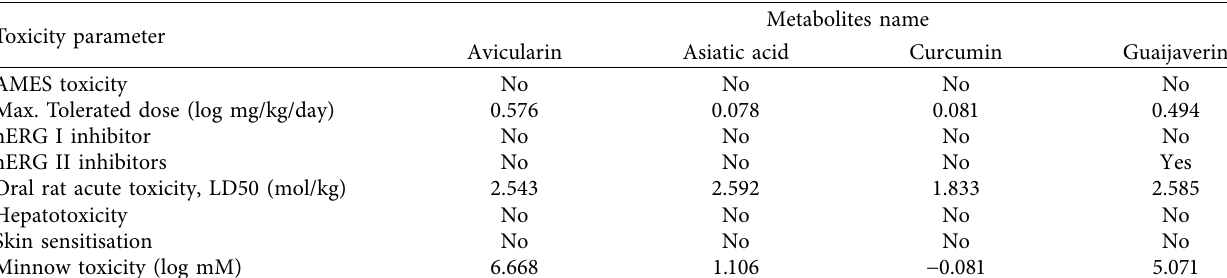
Figure 9: ADME properties of selected metabolites (a) avicularin, (b) Asiatic acid, (c) curcumin, and (d) Table 4: Toxicity parameter of selected chemicals.